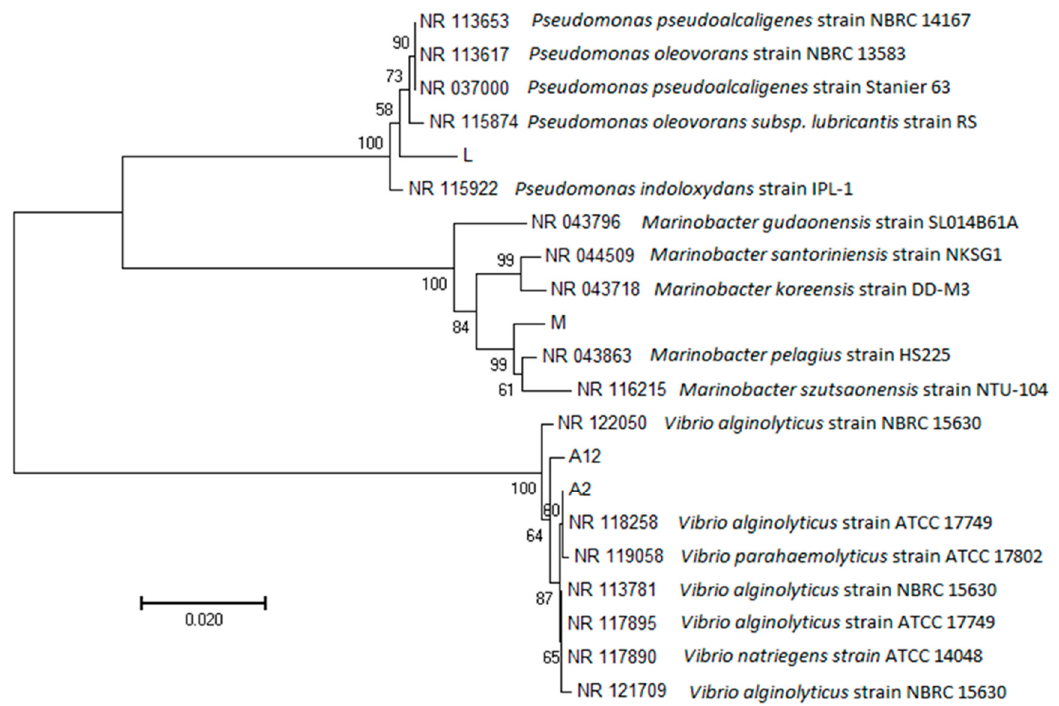
Figure 5. Phylogenetic analysis of 16S rRNA sequences of the four bacterial strains (A2, A12, L, and M). The ruler indicates the scale of the branch length of the tree, which estimates the average number of nucleotide substitutions per site. Bootstrapping values at each branch point indicate times out of 1000 the same branch was observed when repeating the phylogenetic